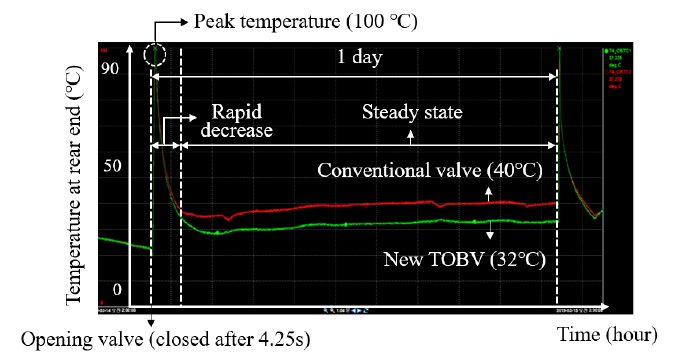
Figure 21. Temperatures at rear end of the new TOBV and the conventional one.